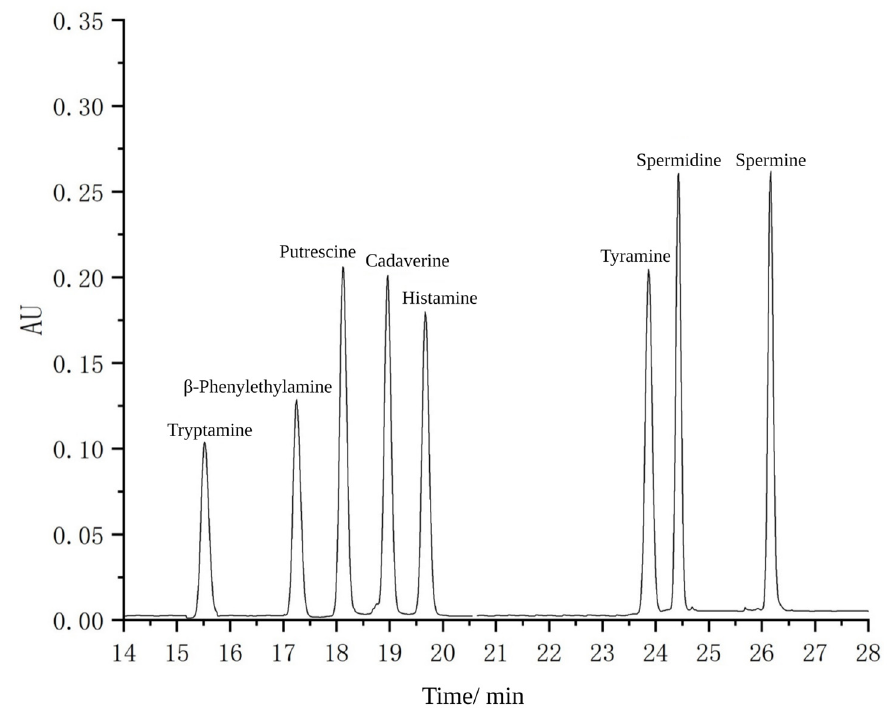
Figure A1. Chromatogram of derivatives of biogenic amines standards (50 µg/mL). Table A1. Regression equations of biogenic amines derivatives.